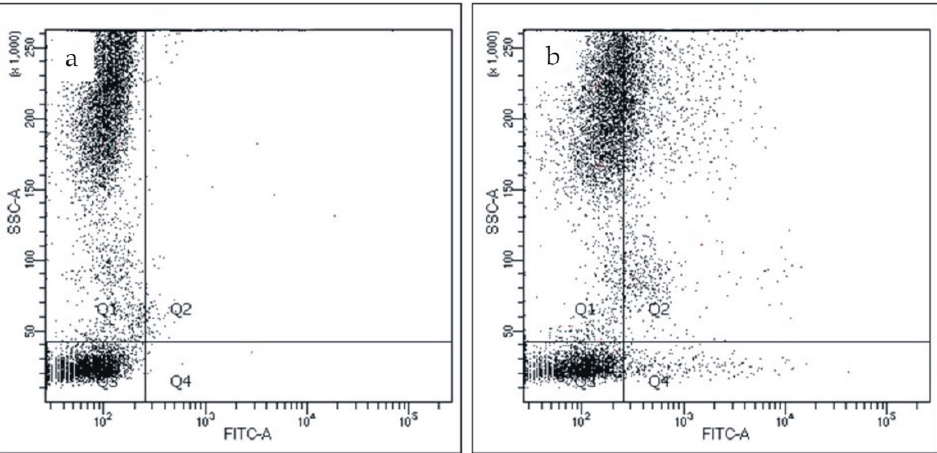
Figure 2. CRP detection on CD45-positive leukocytes. ( a ) The binding of the non-specific FITC-labeled mouse IgG to CD45-positive leukocytes; ( b ) the binding of FITC-labeled monoclonal antibody to pCRP to CD45-positive leukocytes. pCRP—pentameric C-reactive protein.